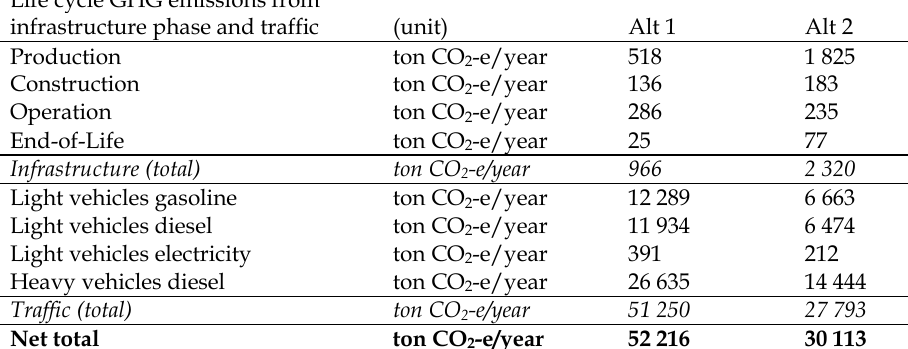
Table 4. Life cycle stage greenhouse gas (GHG) emission contributions Life cycle GHG emissions from infrastructure phase and traffic